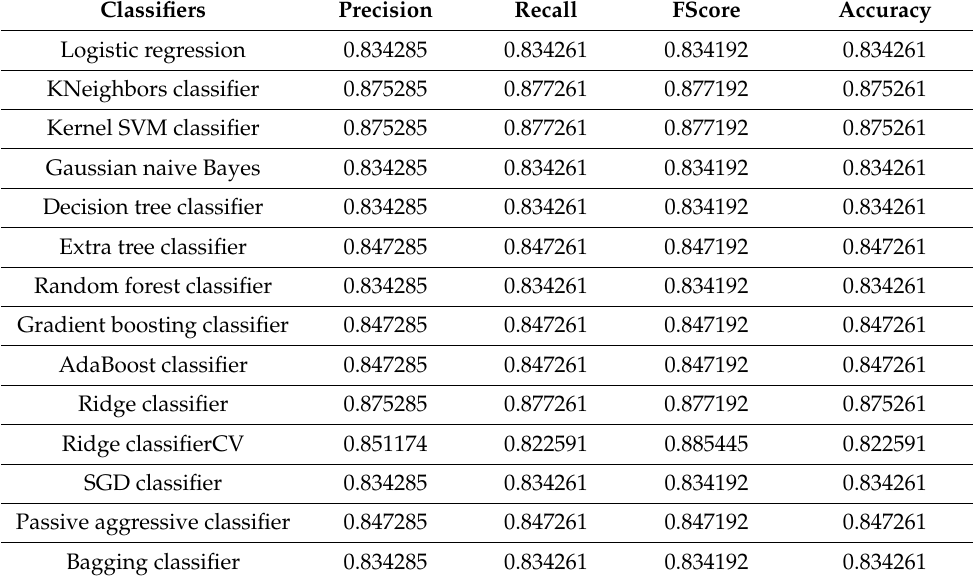
Table 18. AdaBoost classifier metrics after feature